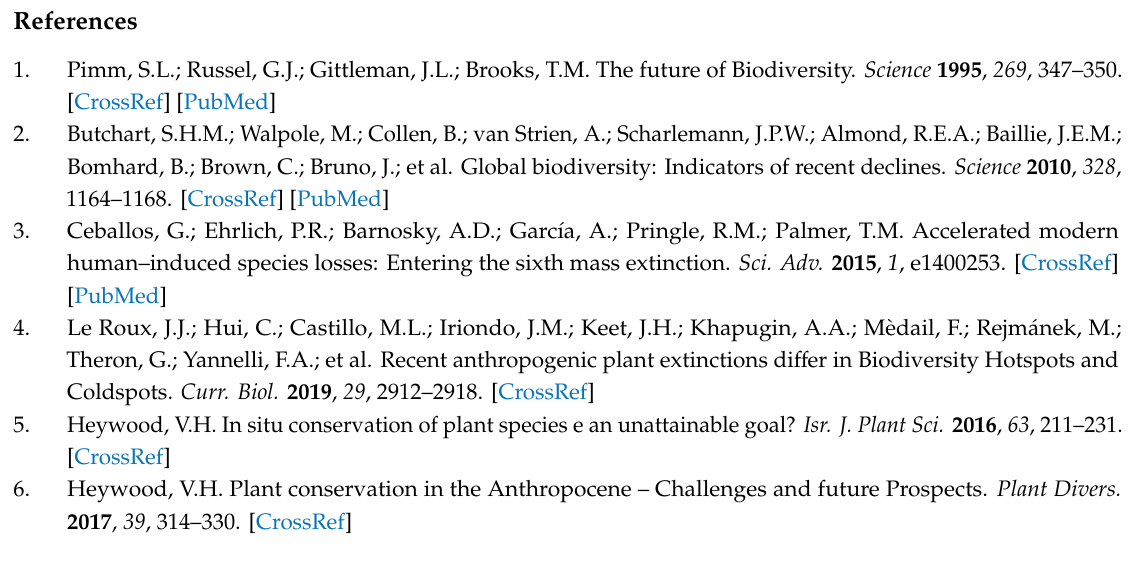
Table S1: Germplasm accessions conserved in the CARE-MEDIFLORA project, Table S2: Germination tests carried out during the CARE-MEDIFLORA project, Table S3: Plant produced in CARE-MEDIFLORA project, Table S4: In situ conservation actions carried out during the CARE-MEDIFLORA